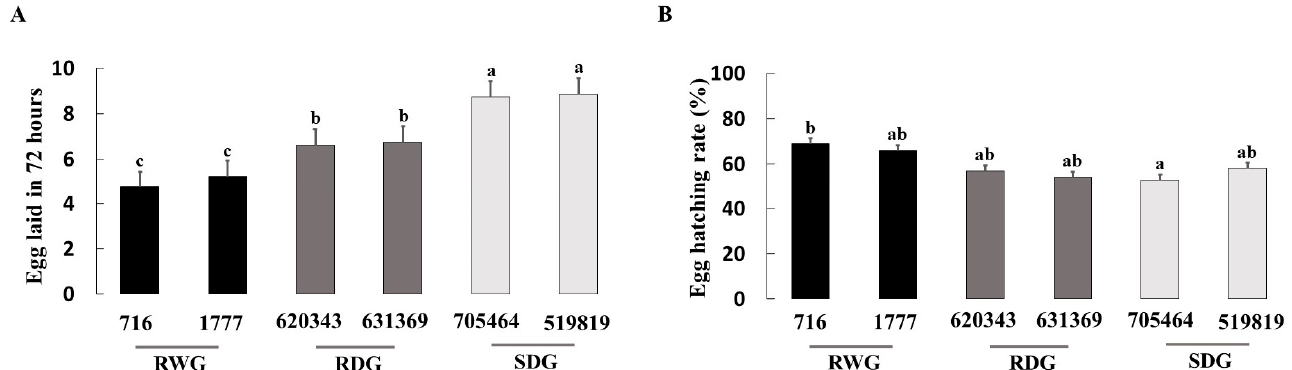
Figure 2. Mean number ( ± SE) of eggs laid by Orius laevigatus in 72 h ( A ) and egg hatching rate ( B ) on six tomato genotypes with different levels of resistance to Phthorimaea absoluta . Bars with shared letters do not differ significantly (one-way ANOVA; Tukey test; p ≤ 0.05). RWG = resistant wild genotypes; RDG = resistant domesticated genotypes; and SDG = susceptible domesticated geno- types.